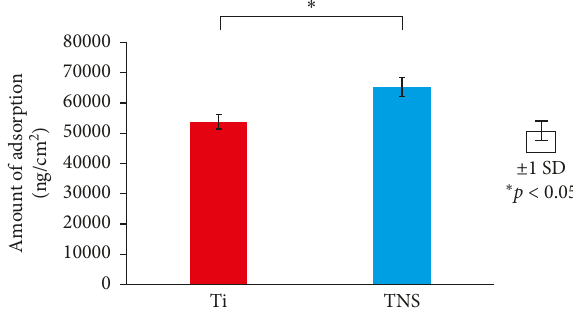
Figure 10: Adsorption of apatite on Ti and TNS QCM